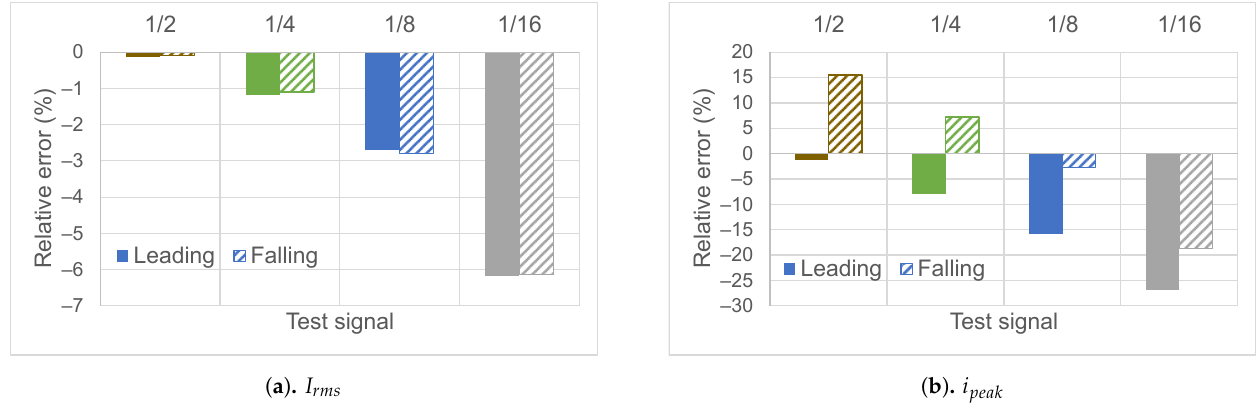
Figure 11. “Leading” and “falling” tests relative error: ( a ) I rms ; and ( b ) i peak